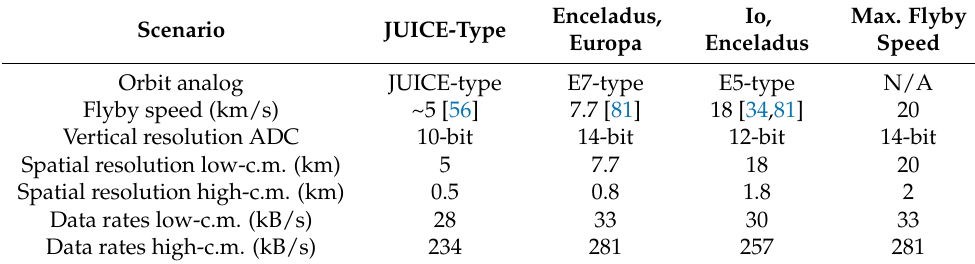
Table 1. Data processing parameters of the OpenTOF instrument in relation to the relative encounter velocities to derive data rates and spatial resolution. An orbit analog is presented, if applicable. The spatial resolutions are presented for the low-cadence mode (low-c.m.) and the high-cadence mode